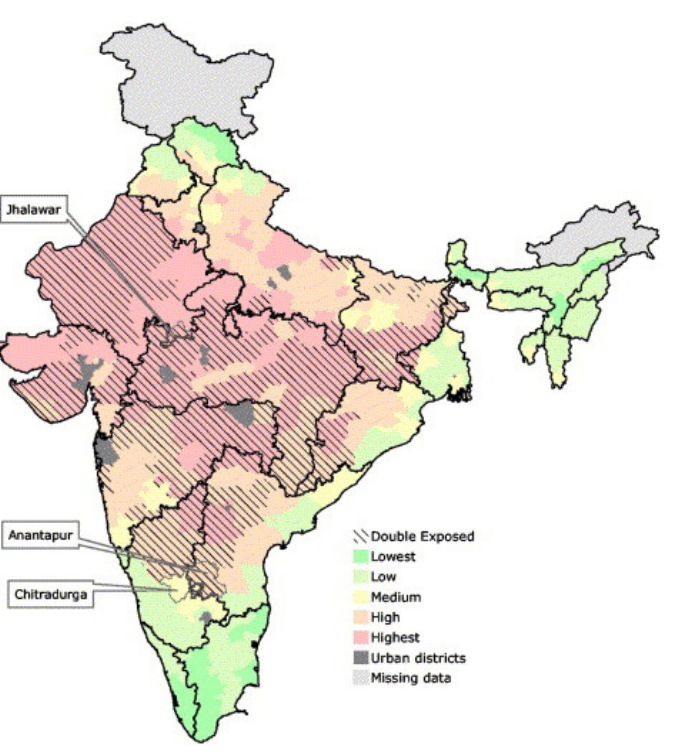
Figure 3. Distribution of vulnerability to the dual exposure to climate change and globalization in India [74].